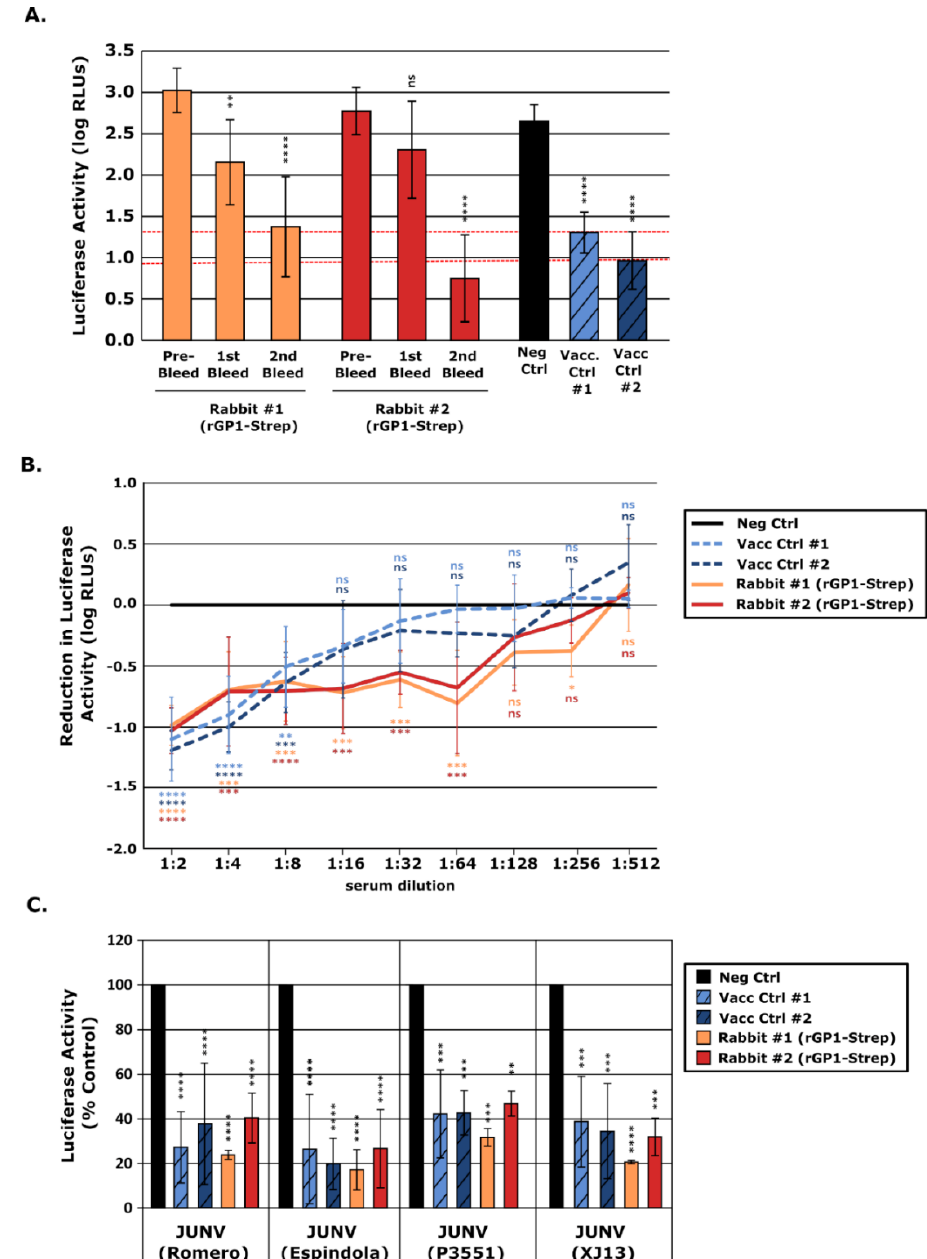
Figure 4. Assessment of neutralizing antibody development following vaccination with recombinant Jun í n virus (JUNV) GP1 based on neutralization of transcription and replication-competent virus-like particles (trVLPs). ( A ) Development of neutralizing antibodies in response to vaccination. trVLPs containing the GP of JUNV (strain Romero) were incubated 1:1 (i.e., final 1:2 dilution) with serum from rabbits vaccinated with rGP1-Strep collected before or during the immunization process, as indicated. Serum from human Candid#1 vaccinees (Vacc Ctrl) or a control pooled human AB serum served as additional controls. Samples were incubated for 2 h at 37 ◦ C before being used to infect Huh7 cells pre-transfected with plasmids expressing JUNV NP and L. After 48 h, these cells were harvested and their nanoluciferase activity measured (as a measure of viral RNA synthesis). Data from at least two independent experiments are represented and the results of a one-way ANOVA comparison to control antibody treated samples are shown. ( B ) Titration of neutralizing